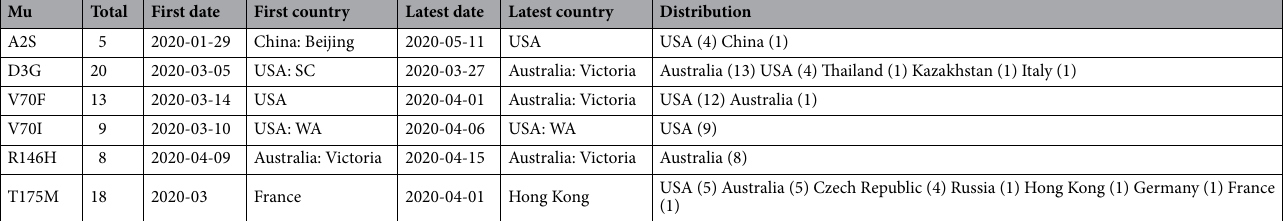
Table 14. Gene M—nonsynonymous mutations occurring in 5 or more